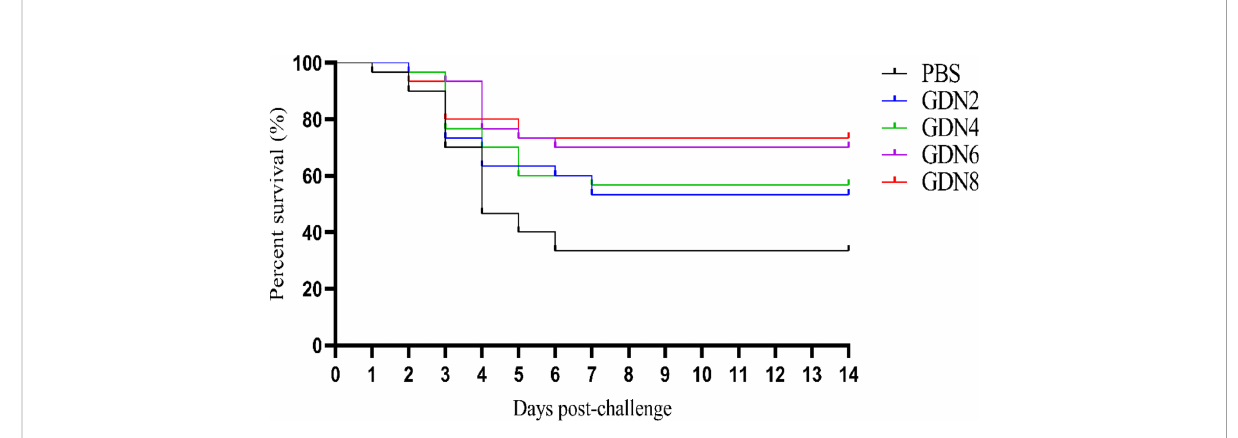
FIGURE 1 Survival rate of pearl gentian groupers challenged with V. harveyi for 14